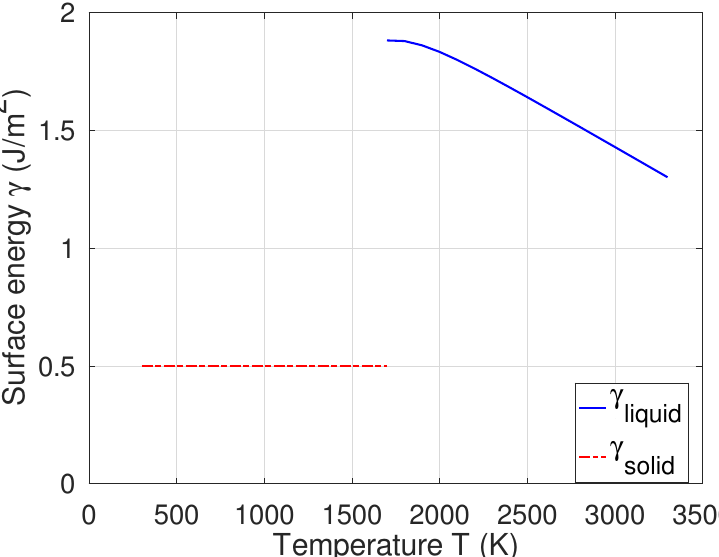
Figure 3. Surface energies ( γ ) of the solid and liquid phases as functions of temperature (results of the calibration